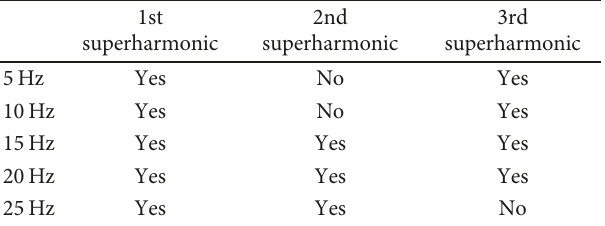
2nd 3rd superharmonic superharmonic